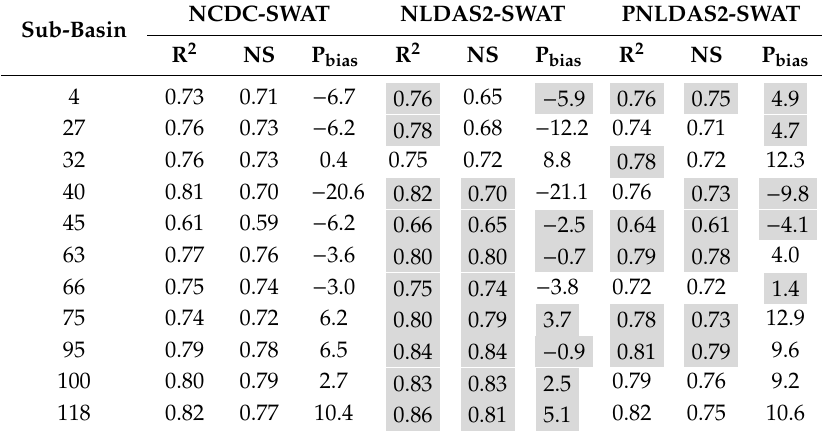
Table 3. Model performance on monthly stream flow at 11 monitoring stations in three scenarios during calibration.